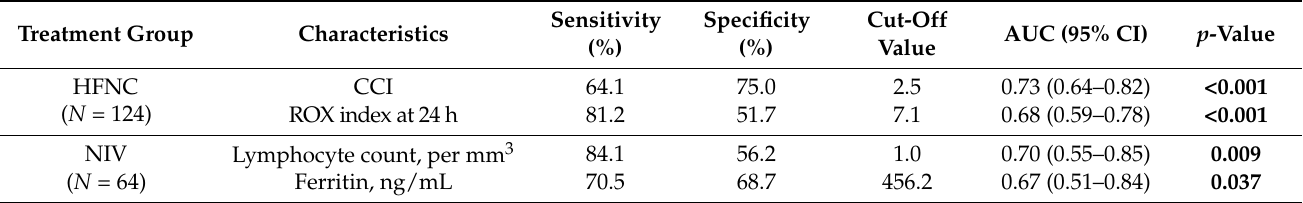
Table 4. ROC curve data of the predictive model for HFNC and NIV failure.